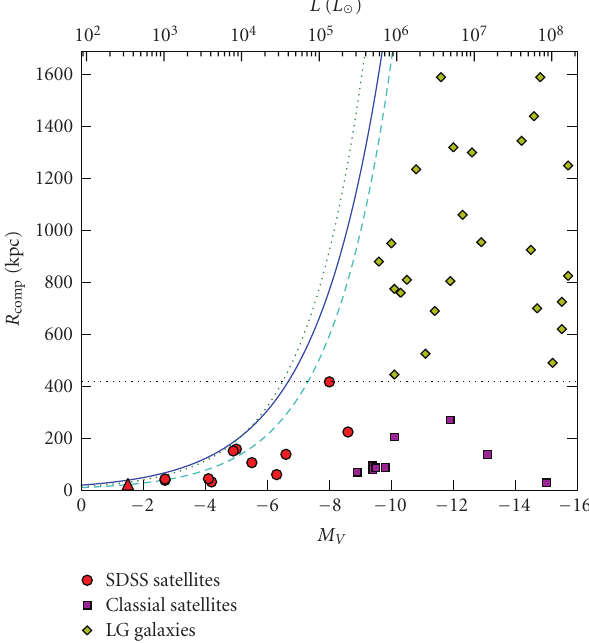
Figure 5: The distance to which the current samples of dwarf satellite galaxies around the Milky Way are complete (dotted, solid and dashed lines correspond to somewhat di ff erent assumptions about detection limits of dwarf galaxies, see [56] for details) as a function of galaxy luminosity (absolute V-band magnitude on the bottom scale and physical luminosity in units of solar luminosity at the top scale). The points show di ff erent types of observed satellites around the Milky Way and in the Local Group. The horizonthal dotted line indicates the outer radius for satellites counts shown in the Figure 6. Note that the completeness distance of the faintest recently discovered satellites is (cid:2) 50 kpc. Adopted from [56].